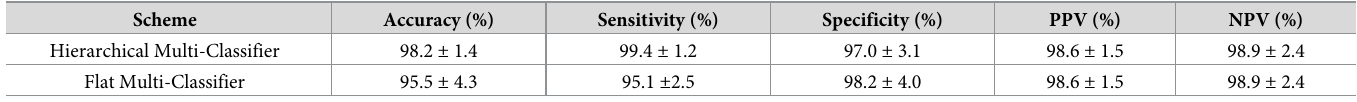
Table 4. Classification performance of our model using CorrTF features (mean ± standard deviation).